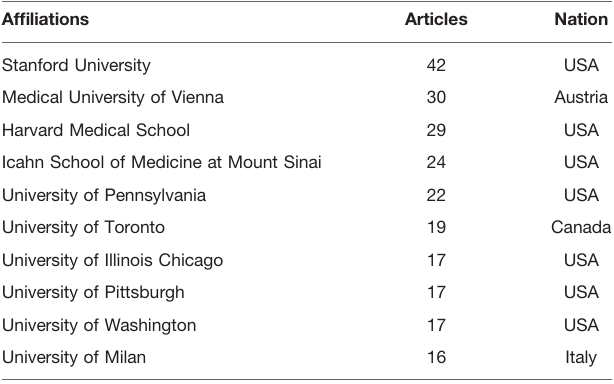
TABLE 2 | The top 10 most productive af fi liations of stem cell precision medicine research. Af fi liations Articles